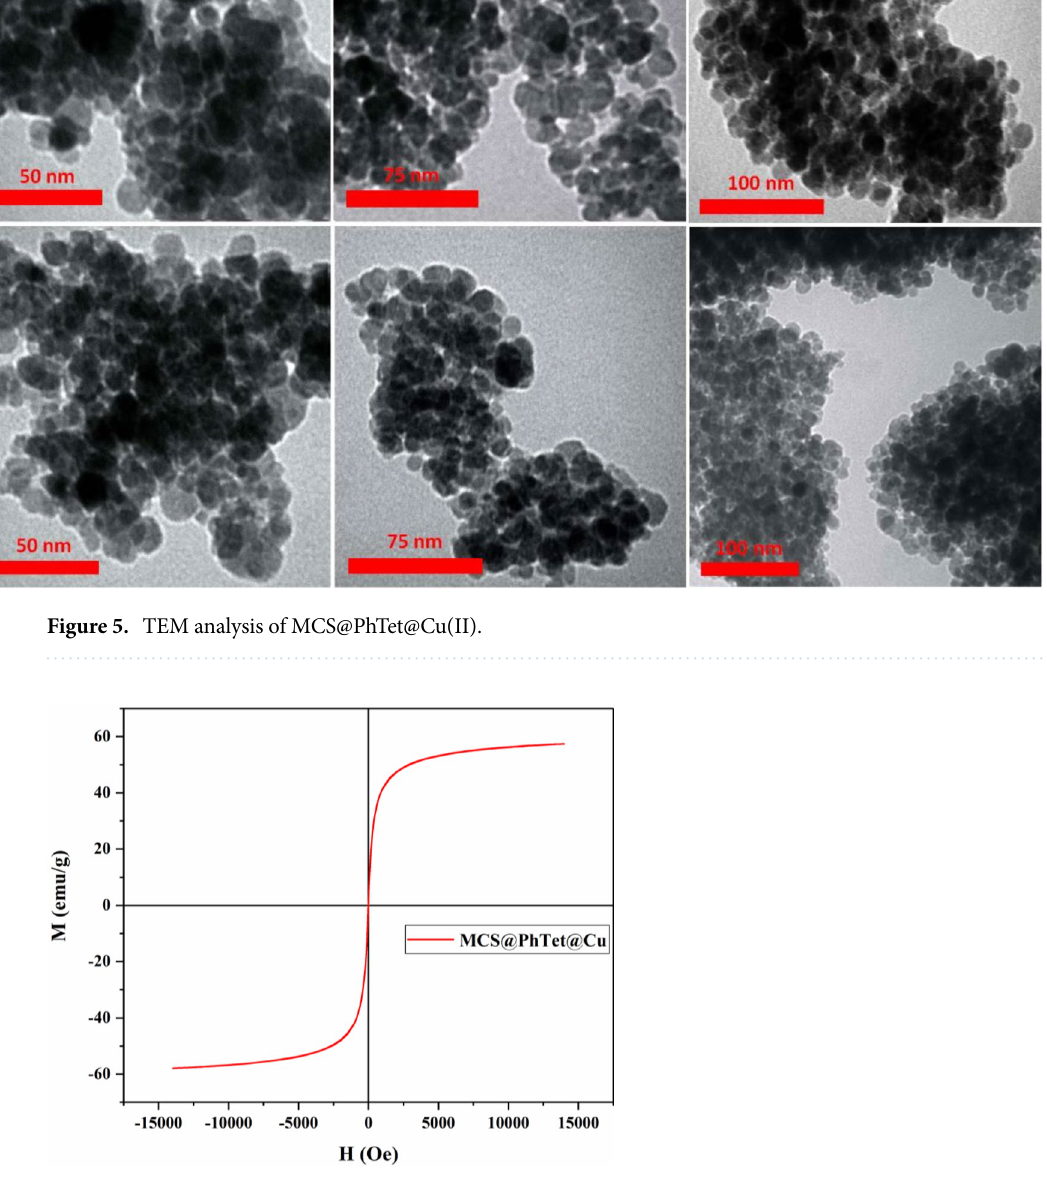
Figure 6. VSM spectrum of